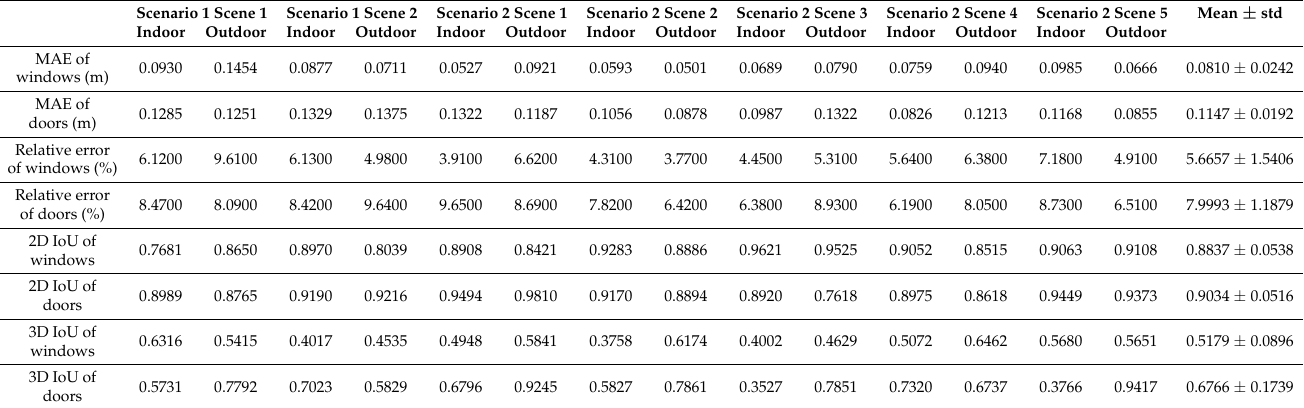
Table 2. The accuracy of the windows and doors